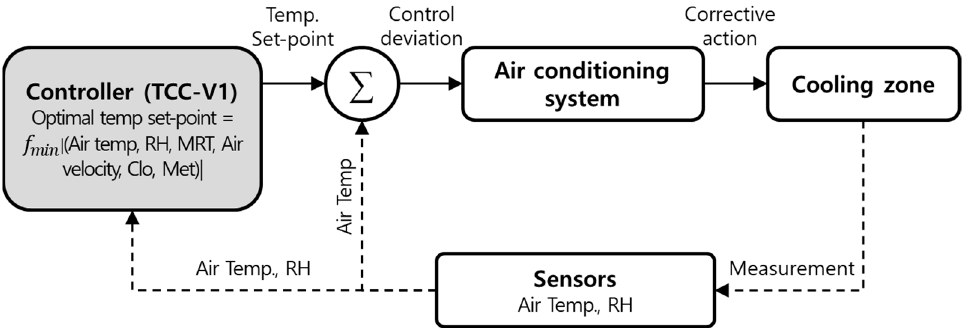
Figure 14. Operational flowchart of TCC-V1.